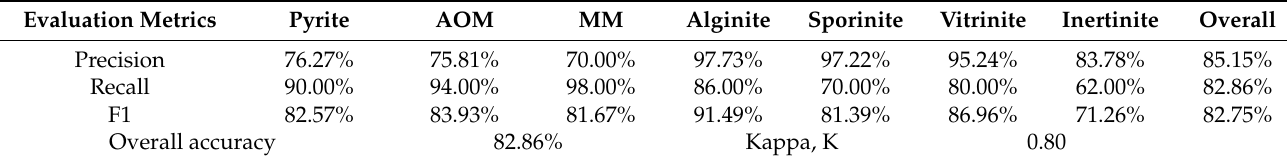
Table 2. Accuracy evaluation of the classification